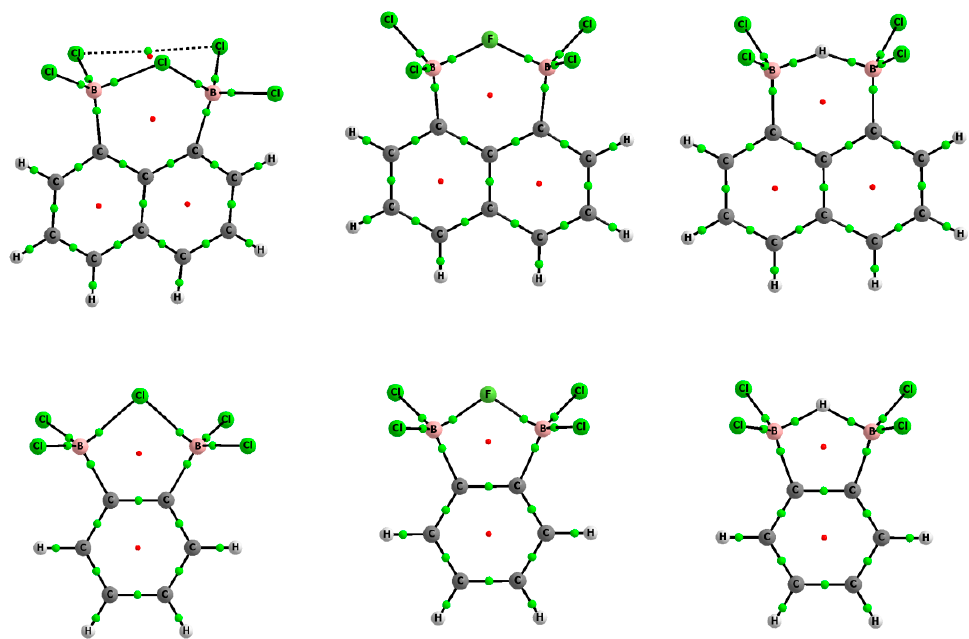
Figure 1. Molecular graphs of 1,8-bis(dichloroboryl)naphthalene ( top ) and 1,2-bis(dichloroboryl) benzene ( bottom ) chlorides, fluorides, and hydrides; big circles correspond to attractors (atoms) while small ones indicate bond-critical (green) and ring-critical points (red).